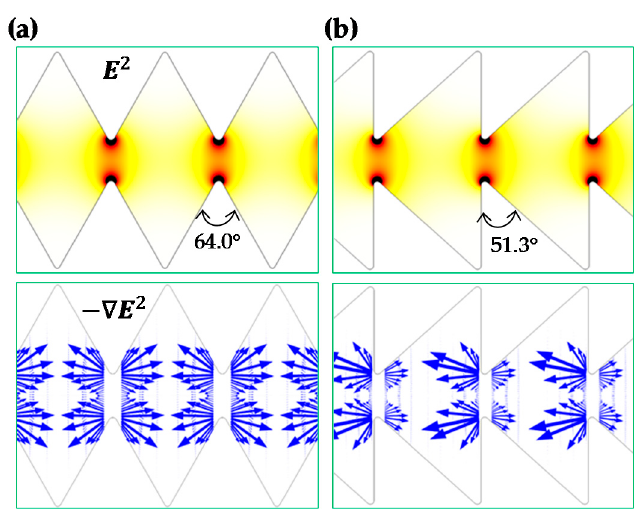
Figure 3. Comparison of the numerically predicted contour of electric field squared (top row), E 2 (the darker color the larger magnitude), and arrows (length proportional to the velocity magnitude) of negative dielectrophoretic particle velocity, U DEP , in terms of −∇ E 2 in between a symmetric ( a ) and an asymmetric (b) ratchet microchannel.